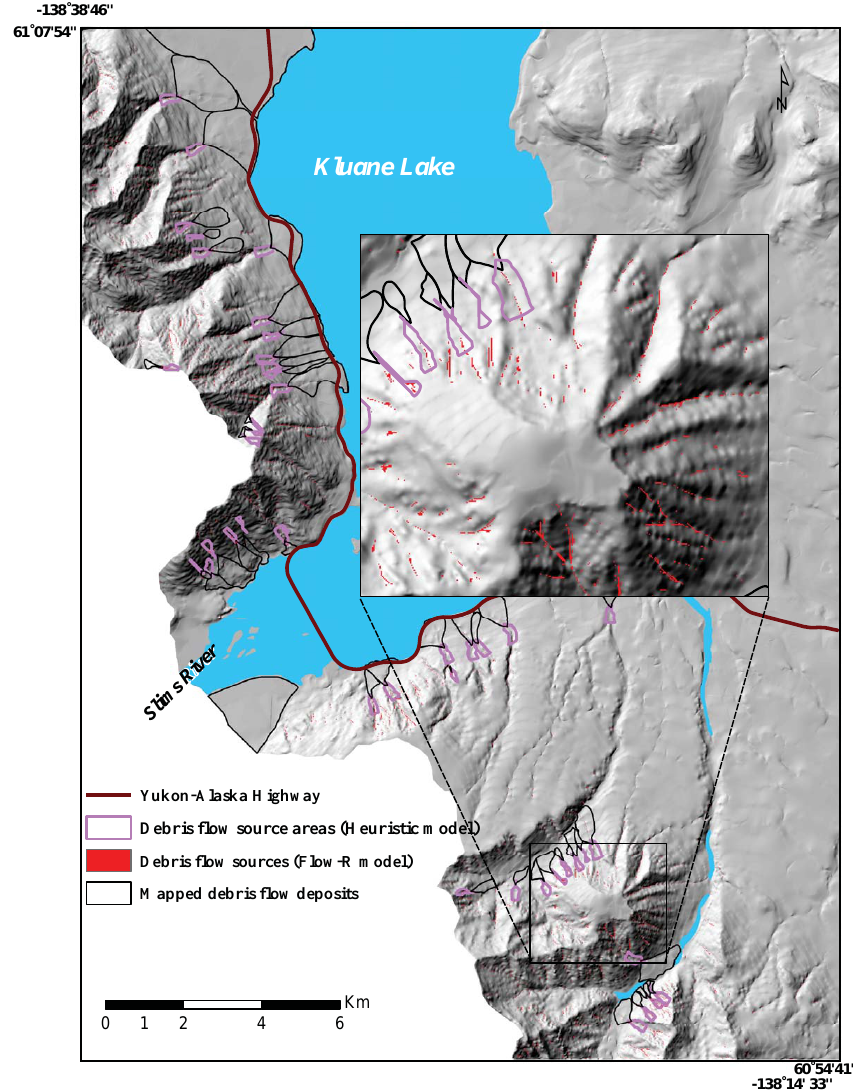
Figure 5. Potential debris flow source areas for the south end of Kluane Lake derived by integrating controlling factors. Inset map displays an enlargement of the calculated source areas (red areas; Flow-R) and the assumed potential source areas (purple lines; Heuristic method). Refer to Fig. 1c for